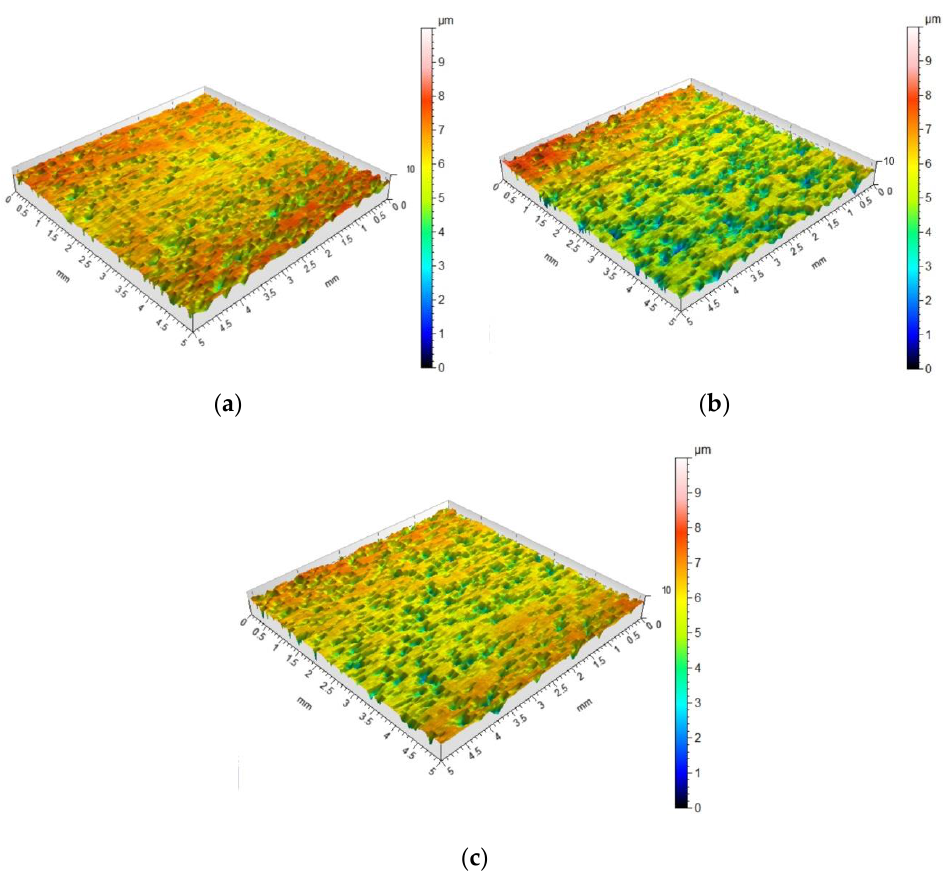
Figure 9. Surface topography of the specimens after a friction test at a nominal pressure of 6 MPa in ( a ) dry friction conditions (Sa = 0.876 µm, Ssk = −1.43, Sku = 5.56, Sp = 2.04 µm, Sv = 6.66 µm, Sz = 8.70 µm, Sa = 0.635 µm), and with ( b ) 5W-30 engine oil (Sa = 1.27 µm, Ssk = −0.698, Sku = 3.65, Sp = 3.47 µm, Sv = 5.38 µm, Sz = 8.85 µm, Sa = 0.965 µm) and ( c ) 80W-90 gear oil (Sa = 1.05 µm, Ssk = −1.36, Sku = 4.78, Sp = 2.46 µm, Sv = 5.88 µm, Sz = 8.34 µm, Sa = 0.782 µm).